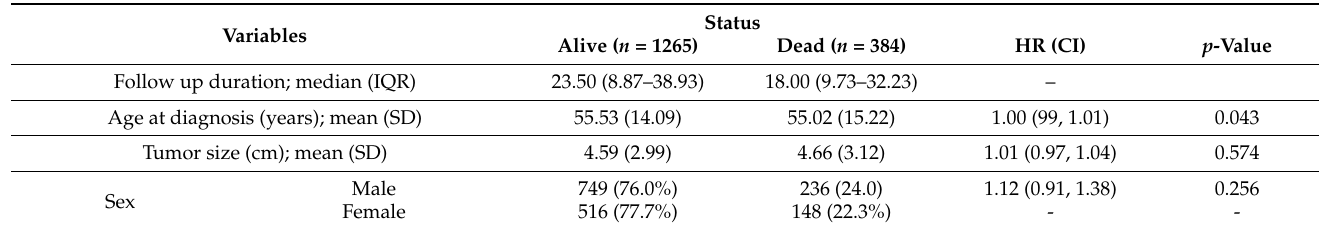
Table 1. Demographic and clinical characteristics; univariable Cox model results to explore the effect of demographic and clinical characteristics variables on survival among patients with